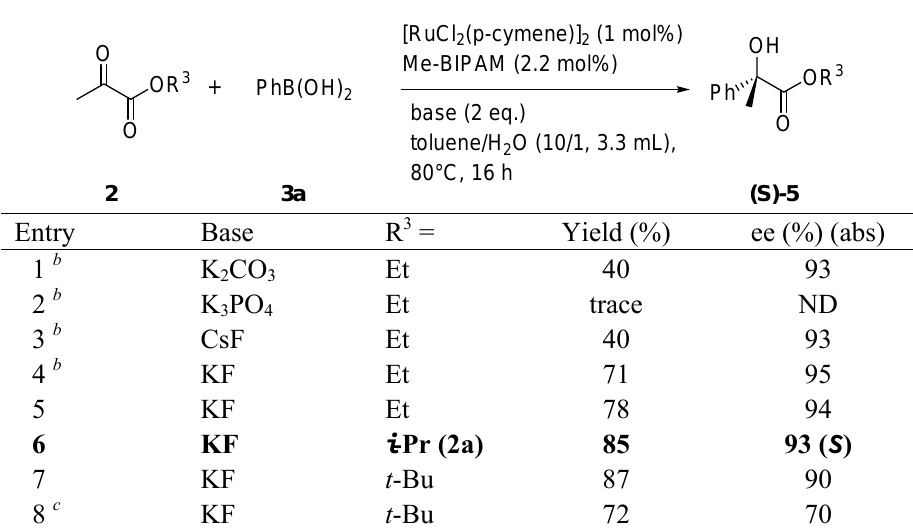
Table 2. Reaction conditions a